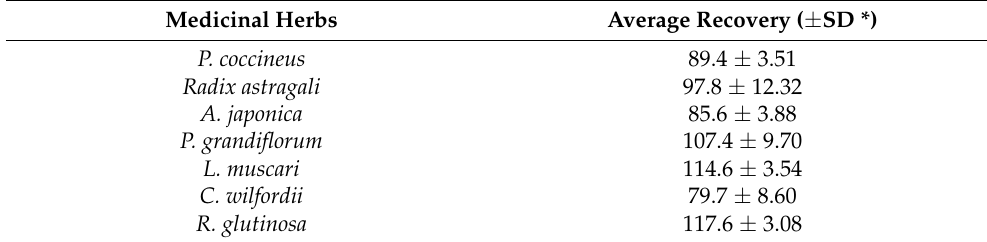
Table 1. Recovery (%) of indoxacarb in 7 medicinal herbs analyzed by GC– µ ECD. Medicinal